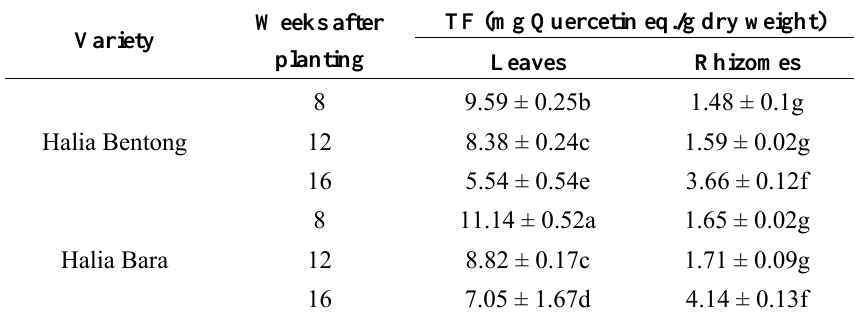
Table 1. Accumulation and partitioning of total flavonoids in different parts of two varieties of Z ingiber officinale at different harvest times (weeks after